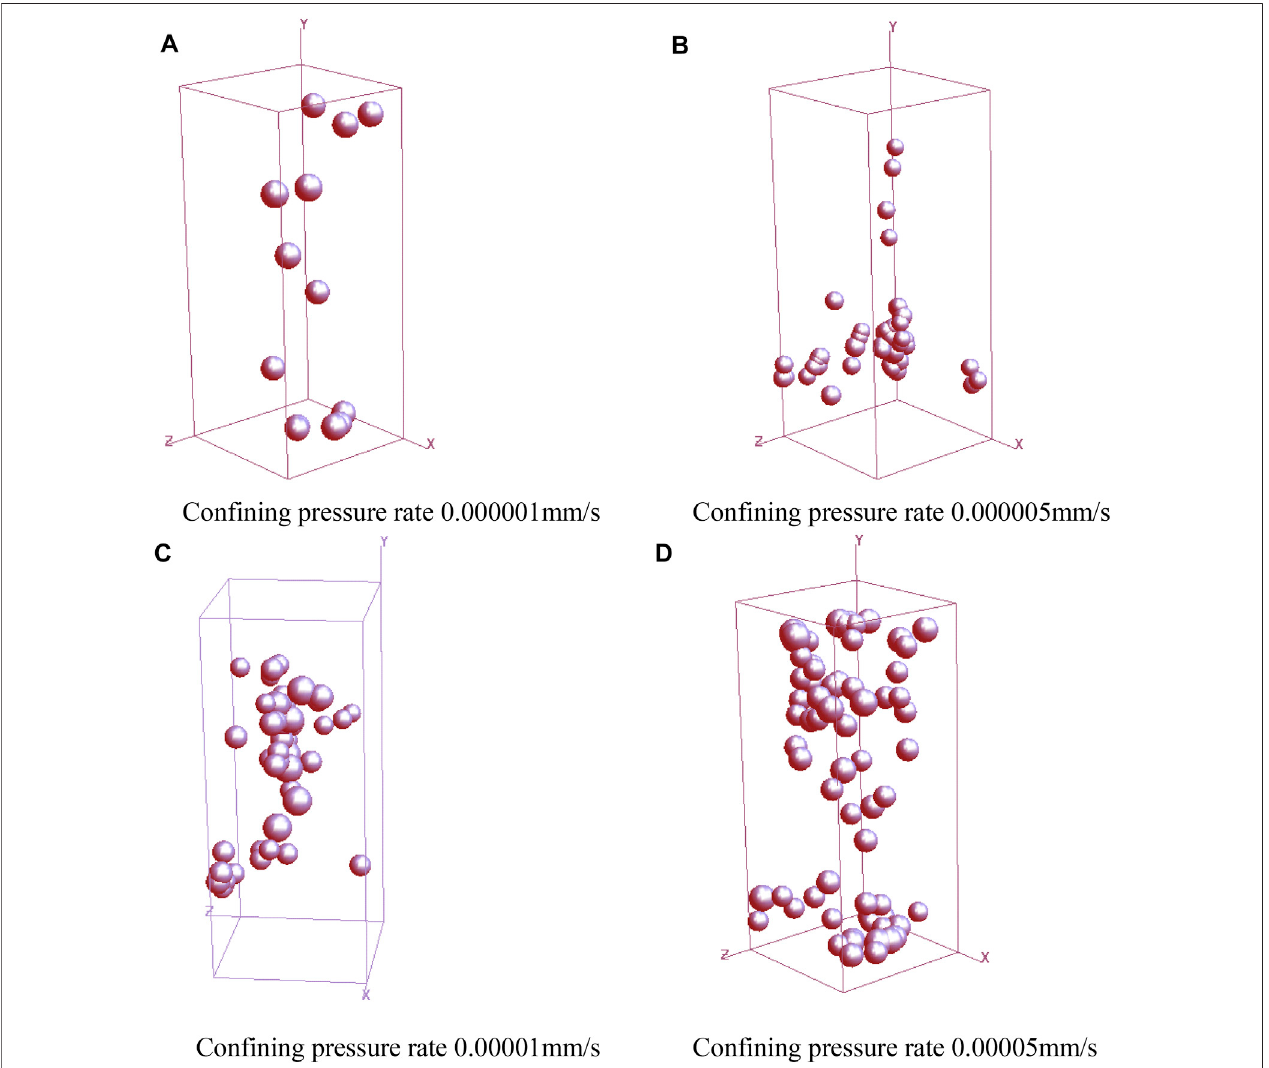
FIGURE 9 | AE morphology of rock specimens under different con fi ning pressures at 400 steps. (A) is the 400-step result of model acoustic emission at the con fi ning pressure rate of 0.000001 mm/s. (B) is the 400-step result of model acoustic emission at the con fi ning pressure rate of 0.000005 mm/s. (C) is the 400-step result ofmodel acoustic emission at the con fi ning pressure rate of0.00001 mm/s. (D) is the 400-step result ofmodel acoustic emission at the con fi ning pressure rate of 0.00005